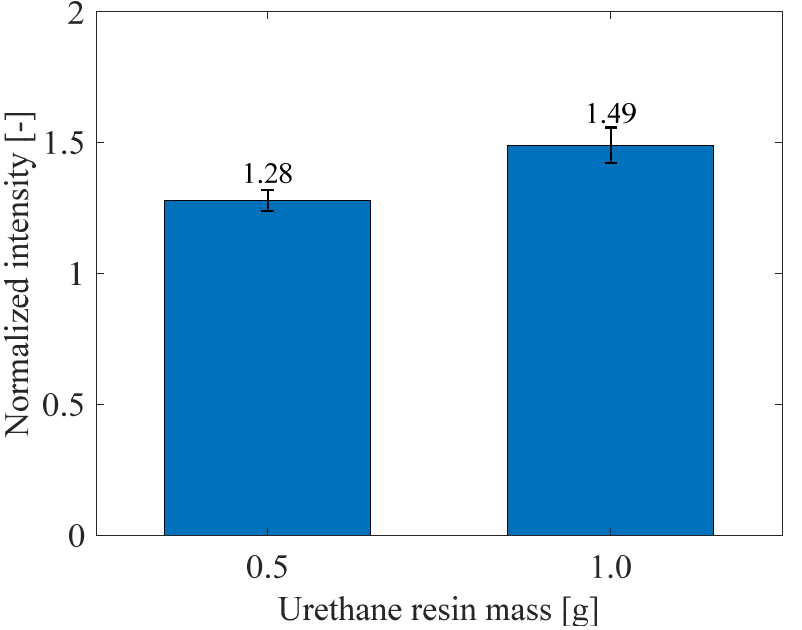
Figure 18. Normalized luminescence intensities of PC-PSPs with different amounts of urethane